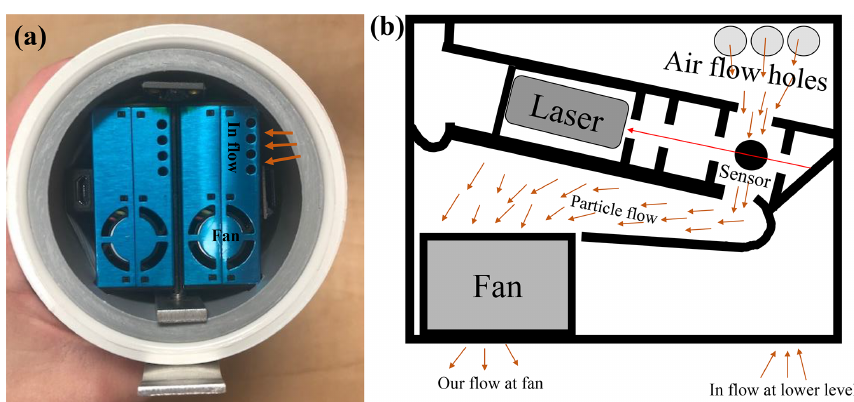
Figure 1. (a) Picture from the bottom of the PA-II unit containing two PMS5003 sensors (in blue). (b) Schematic of a single PMS5003 sensor. A fan draws the particles through the inflow (rounded holes) at the lower level of the sensor. The particles travel to the upper part of the sensor where they come out through the air flow holes and then pass through the laser path, causing the beam to scatter. Finally, the particles exit from the